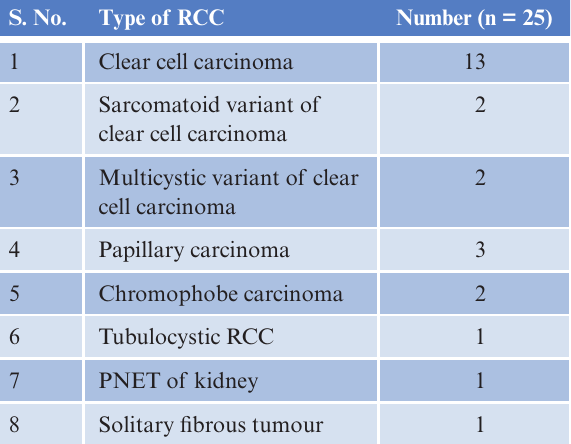
Table 4: Histopathology in patients <50 years of age. S.